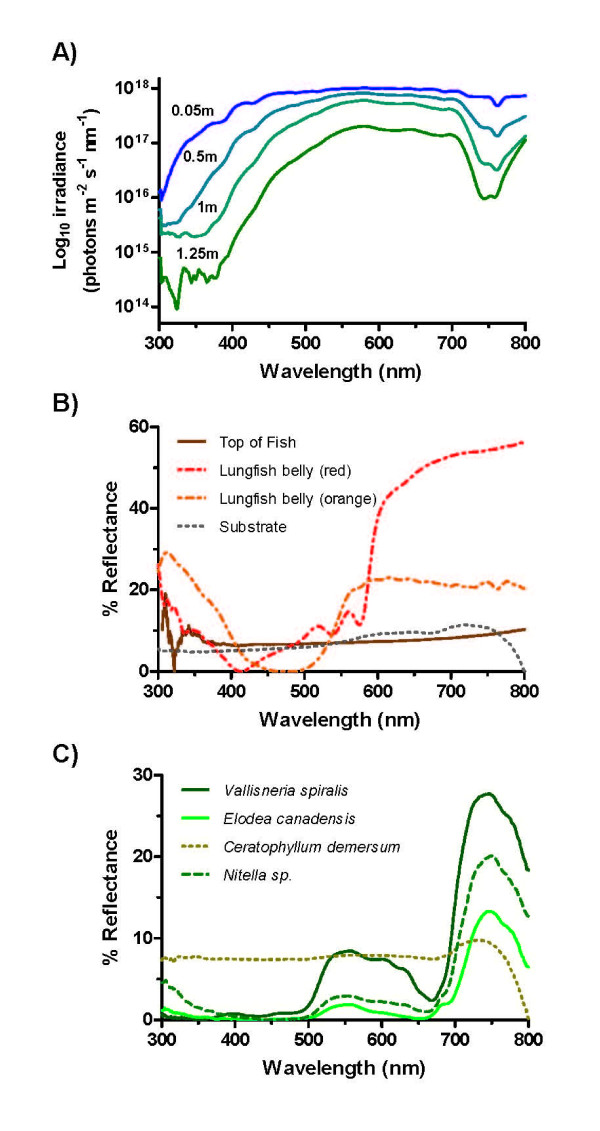
Habitat irradiance and reflectance spectra of objects of potential importance to the visual ecology of lungfish. (A) Downwelling spectral irradiance at increasing depths in a typical lungfish habitat, the Mary River, Queensland, Australia. Note the rapid attenuation of ultraviolet wavelengths with increasing depth compared to longer wavelengths. (B) Reflectance spectra of lungfish body colours compared to sandy riverbed substrate against which they might be viewed. (C) Reflectance spectra of typical macrophytes found in a typical lungfish habitat, some of which (e.g. Vallisneria spiralis) are eaten or used as spawning sites.